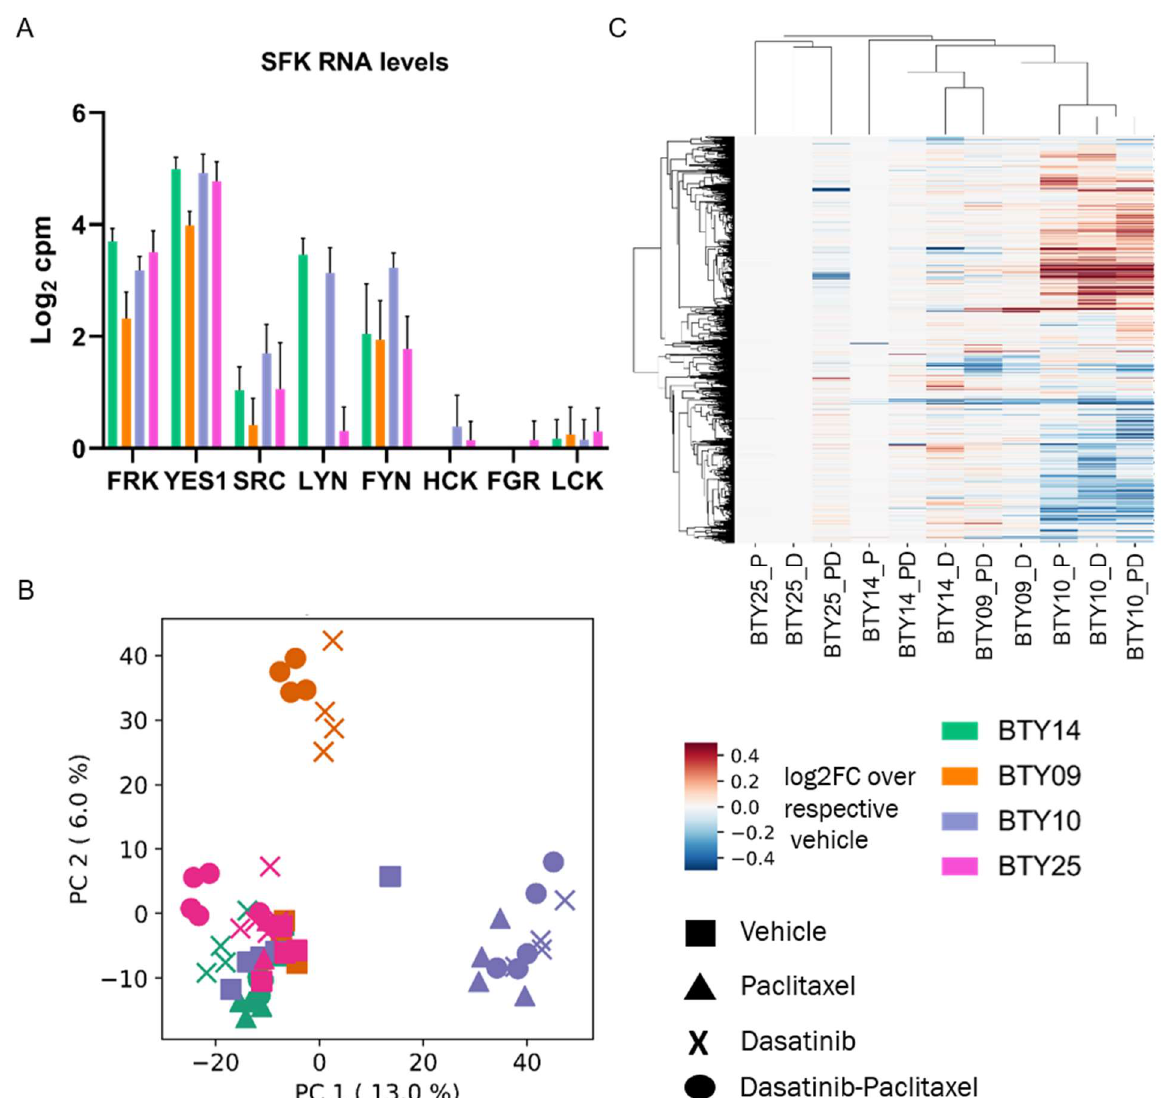
Figure 5. RNA-seq analysis of TNBC PDXs. ( A ) Transcript levels of SFKs quantified in vehicle treated tumors of CR-TNBC PDX lines. Transcript levels are presented as log 2 counts per million reads (cpm). ( B ) PCA plot of transcript levels quantified in drug treated tumors of BTY14, BTY09, BTY10, and BTY25 lines. Transcript levels were normalized by the average of the respective vehicle controls, to assess the effect of drugs on transcriptome ( n = 3–5/group, total 64 PDXs). ( C ) HCA (Euclidean distance metric) heatmap of transcript levels in the same tumors.